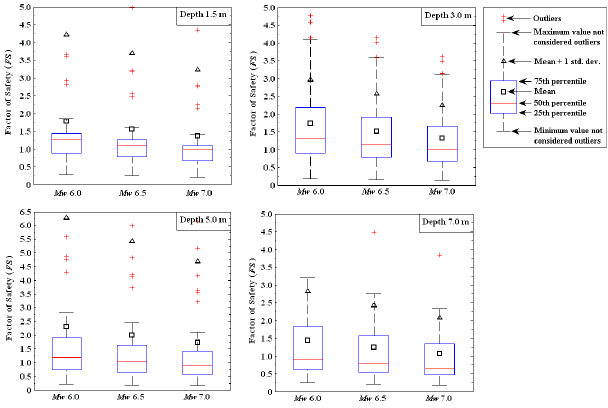
Fig. 5. Factors of safety against liquefaction (FS) for the city for earthquakes of 2475-yr return